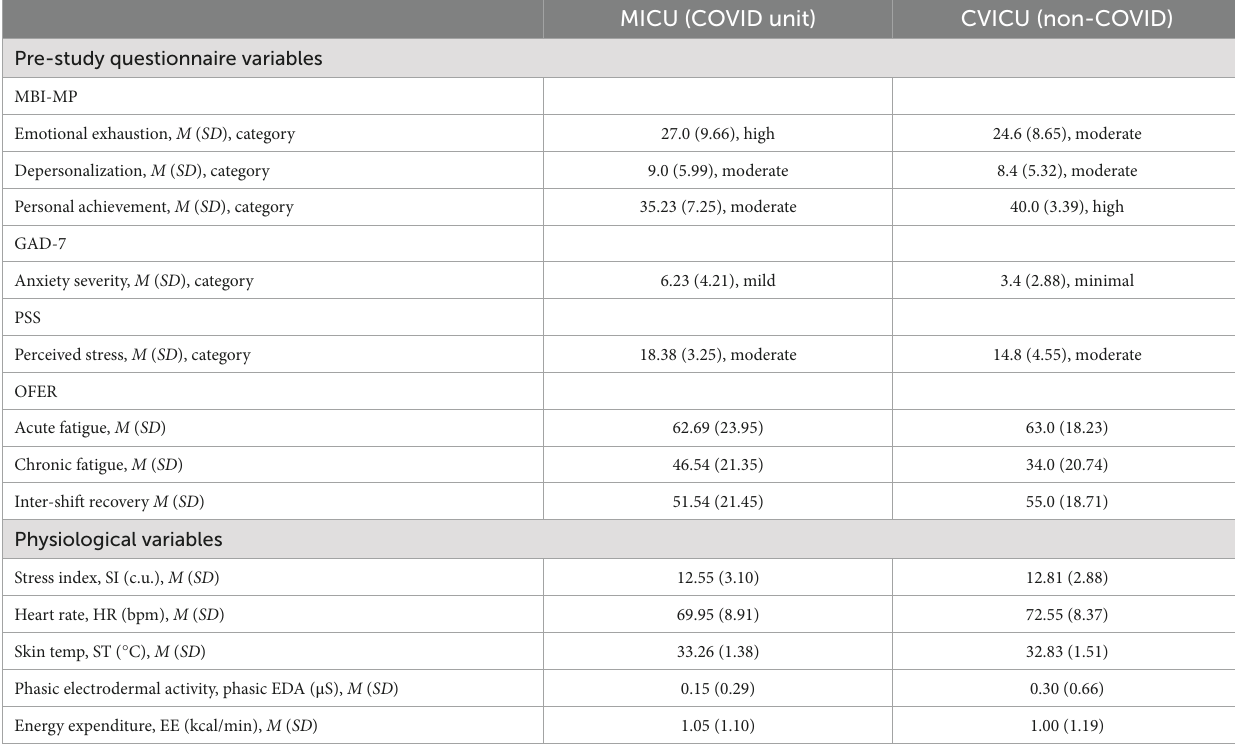
TABLE 2 Descriptive statistics of pre-study questionnaire and physiological variables of participants in MICU and CVICU.